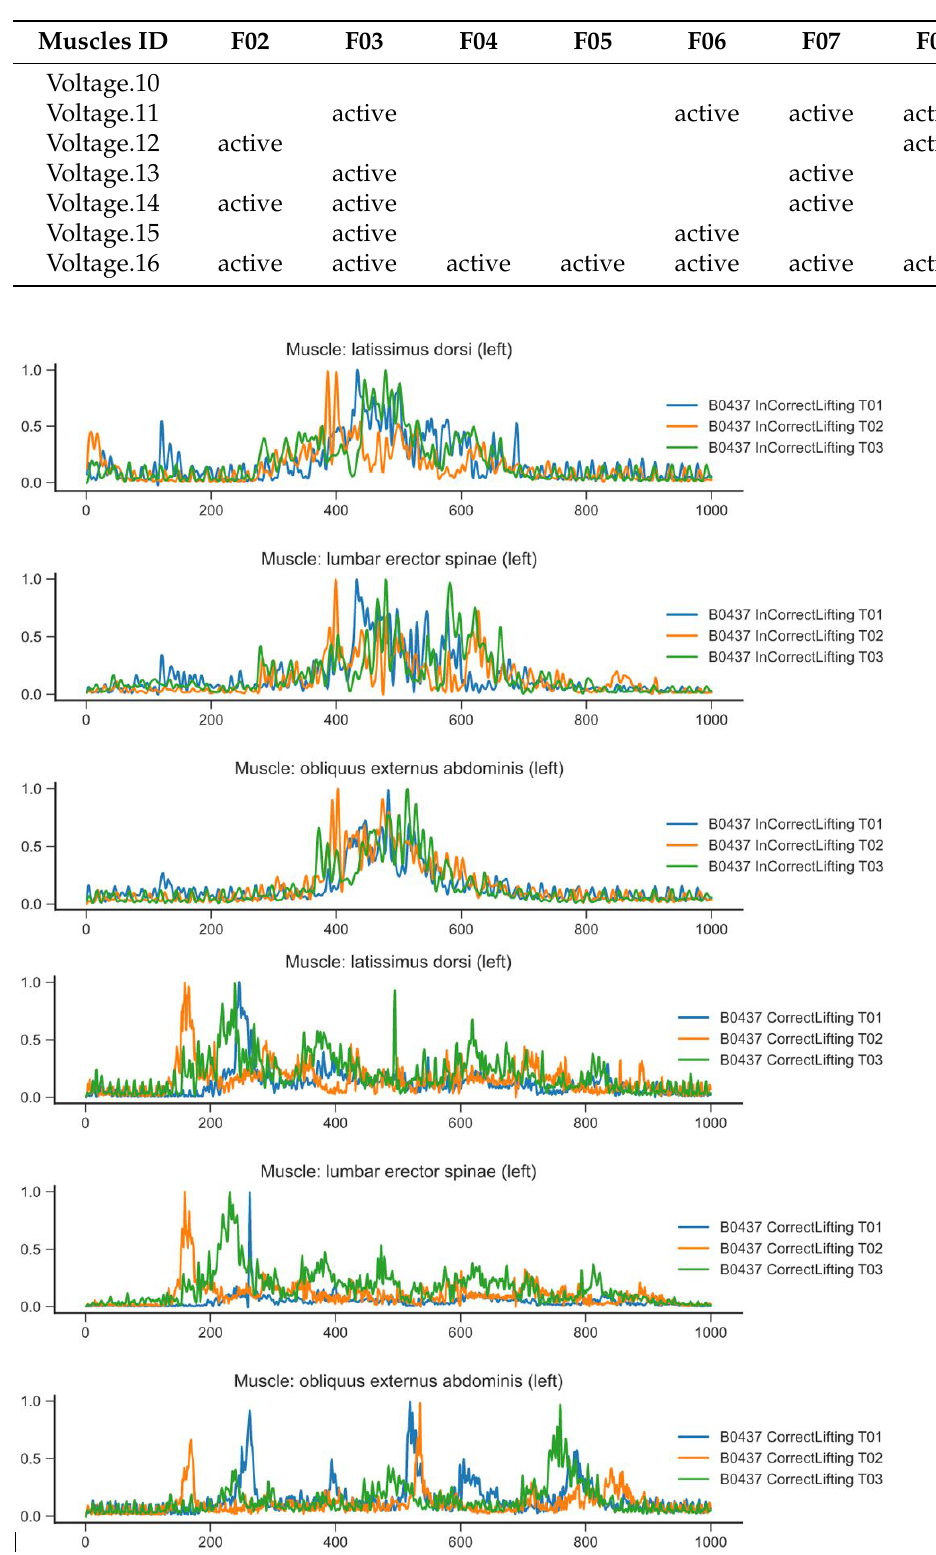
Figure 4. Activity of selected muscles for patient transfer. The first three graphs show the incorrect transfer, the next three graphs show the correct